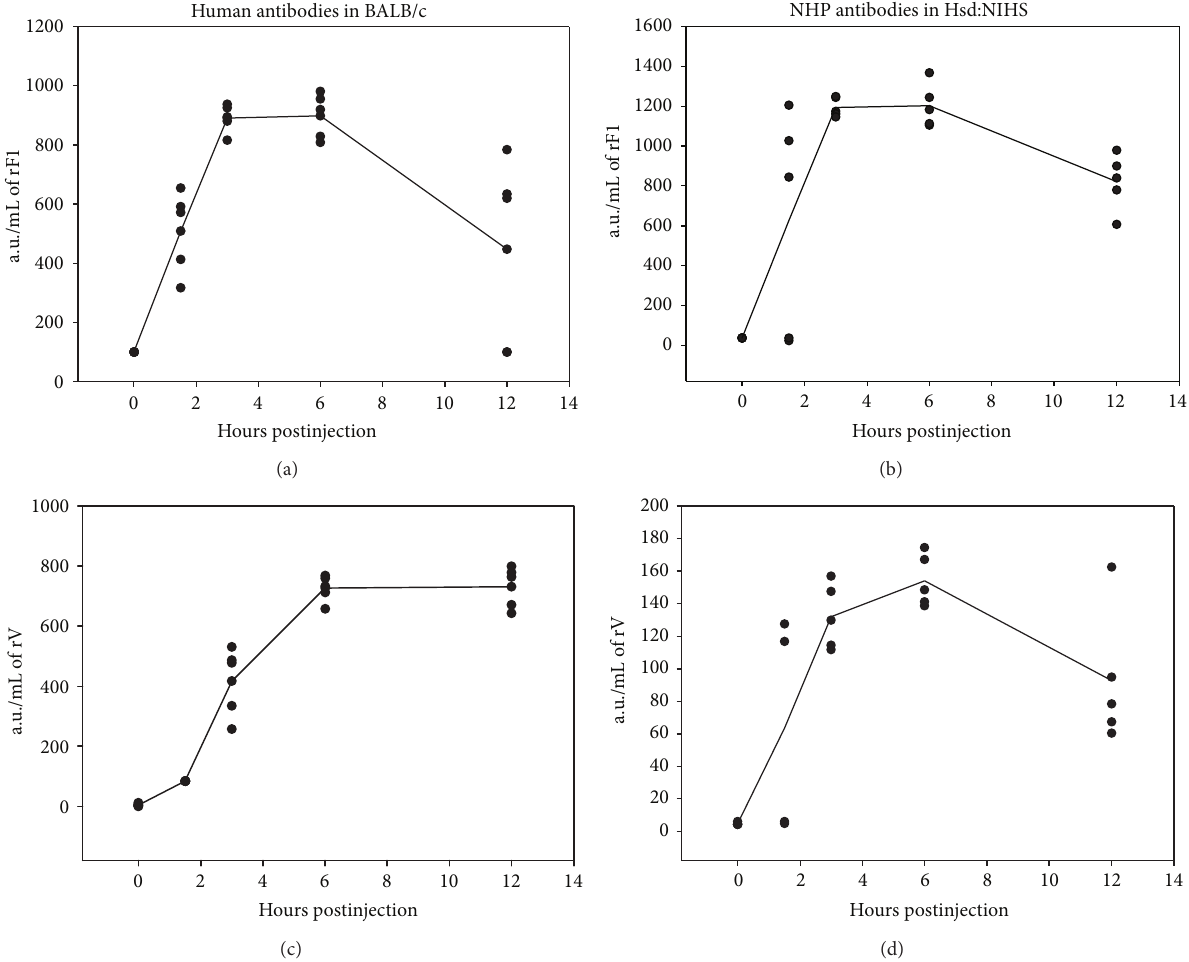
Figure 1: Pharmacokinetics of human or cynomolgus macaque antibody in BALB/c and Hsd:NIHS mice, respectively. 0.25 mL human ((a) and (c)) or cynomolgus macaque ((b) and (d)) plague vaccine serum was injected via the intraperitoneal route into BALB/c ( 𝑛 = 20 ) or Hsd:NIHS ( 𝑛 = 20 ) mice, respectively. The mice were serially sacrificed and the presence of anti-rF1 ((a) and (b)) or anti-rV ((c) and (d)) antibody was assessed by ELISA. Additional groups of mice ( 𝑛 = 5 ) were sacrificed preinjection to provide baseline data. The data suggests that the time delay between passive antibody administration and optimal serum concentration in the murine serum was between 3 and 6 hours. a.u., arbitrary